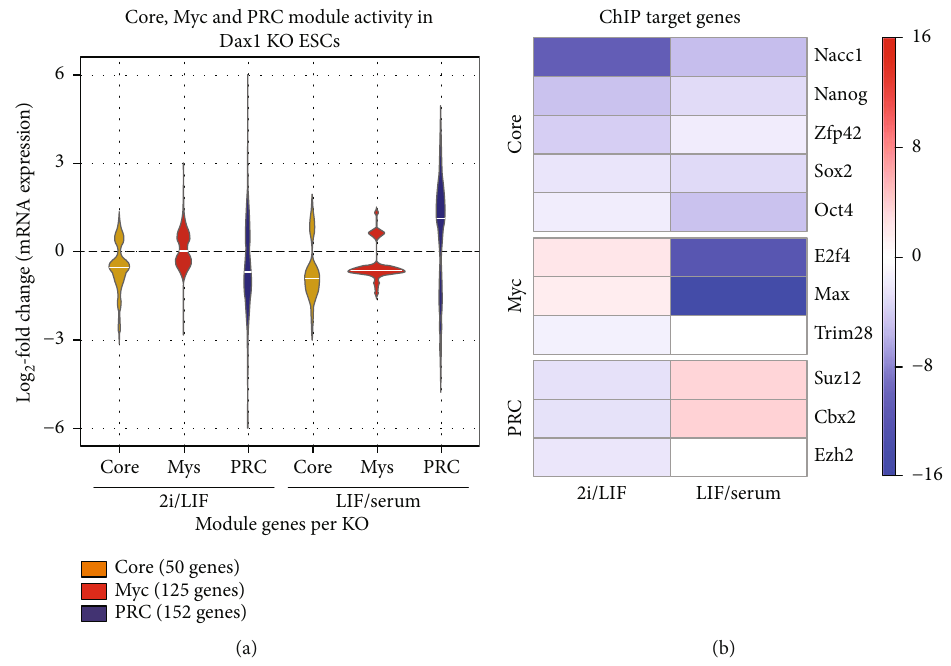
Figure 5: The impact of Dax1KO on signaling pathways and transcription networks (modules) in di ff erent pluripotency states. (a) A violin plot representing changes in CORE, MYC, and PRC module gene expression in Dax1 KO compared to wild-type mESCs cultured in 2i/LIF and LIF/serum medium. (b) Heatmap showing the geometric P values calculated by gene set overlap analysis between gene sets from ChIP- seq and DEGs (Dax1 KO compared to wild-type mESCs cultured in 2i/LIF and LIF/serum). The red cells correspond to upregulated DEGs; blue cells correspond to downregulated DEGs. Color intensity is proportional to log10 ( P